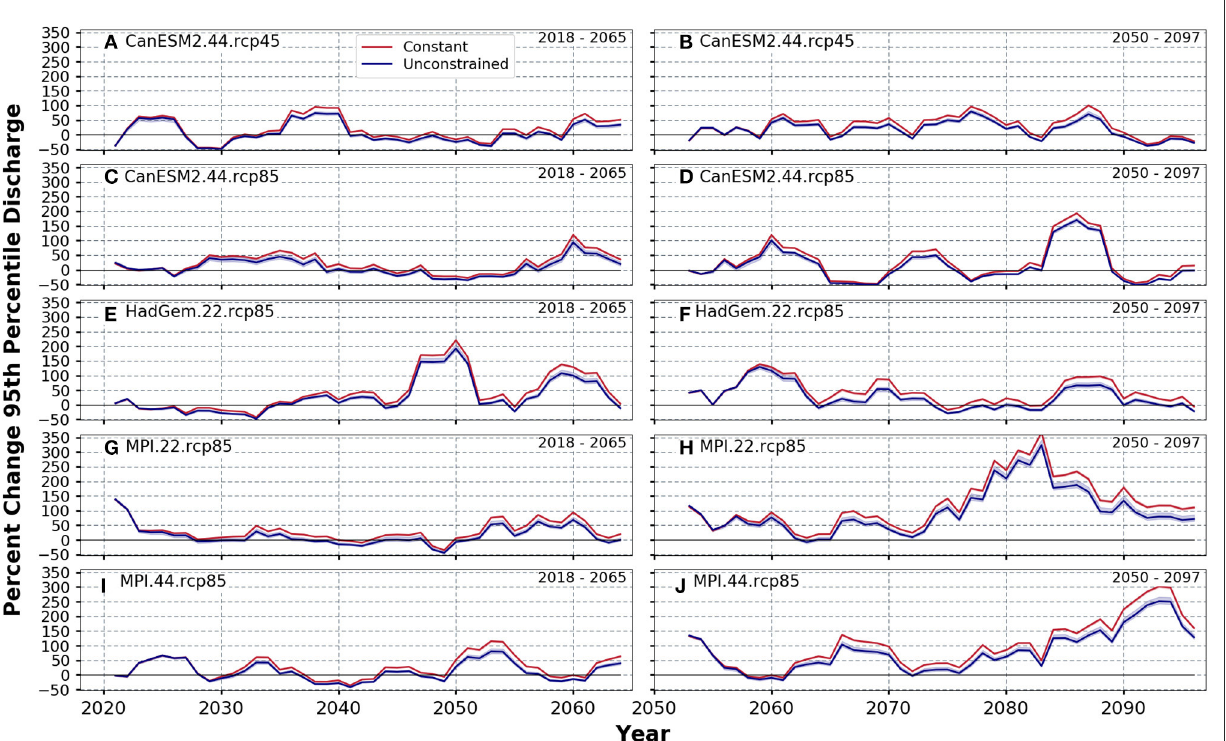
FIGURE6 Percent change in 95th percentile discharge for the constant (red) and unconstrained (blue) scenarios compared to the mean 1970–2016 95th percentile discharge. (A, C, E, G, I) depict change for 2018–2065 and (B, D, F, H, J) depict change for